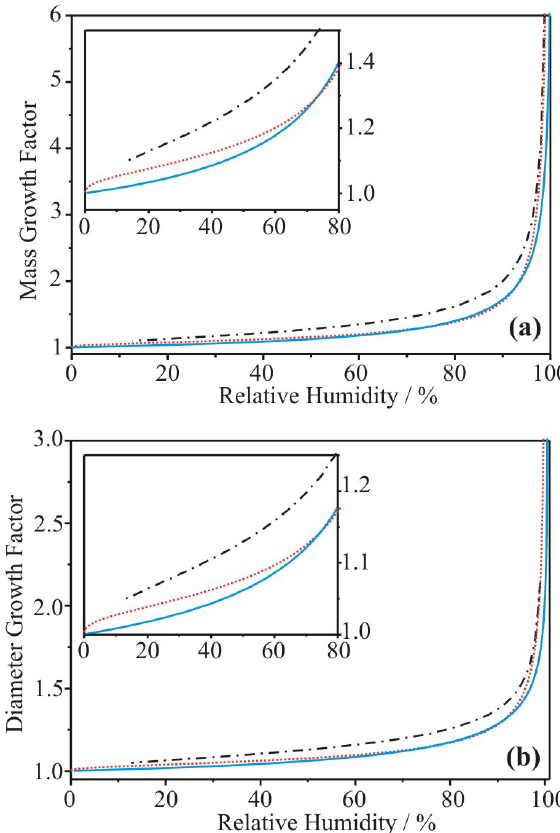
Fig. 3. (a) Mass growth factors as a function of relative humidity based on the water activity data parameterisations of Norrish (dot- ted red line), ADDEM (dash dot black line) and Zobrist (light blue line) for sucrose aerosol. (b) Diameter growth factors for the same treatments (same colours) as (a) using the volume additivity treat- ment of density for sucrose